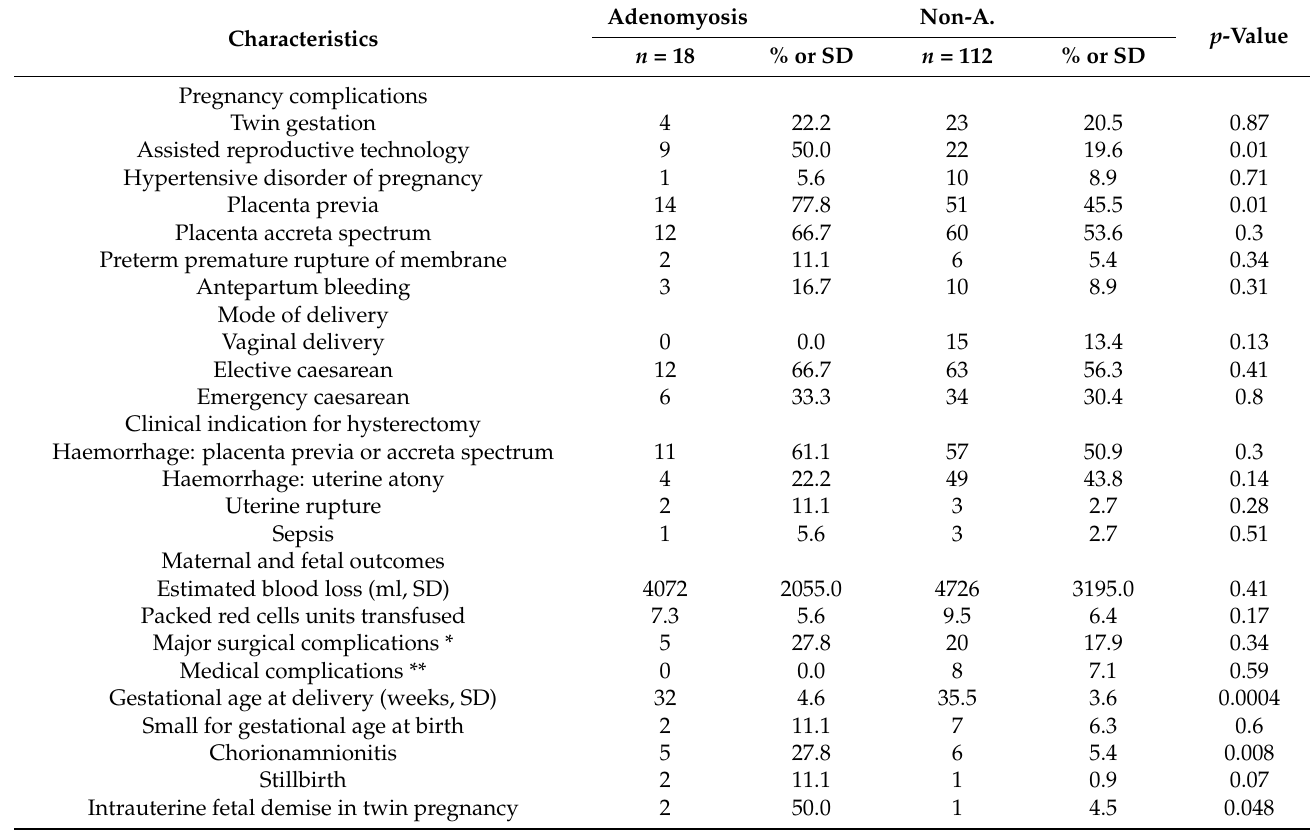
Table 2. Pregnancy outcome stratified by presence or absence of